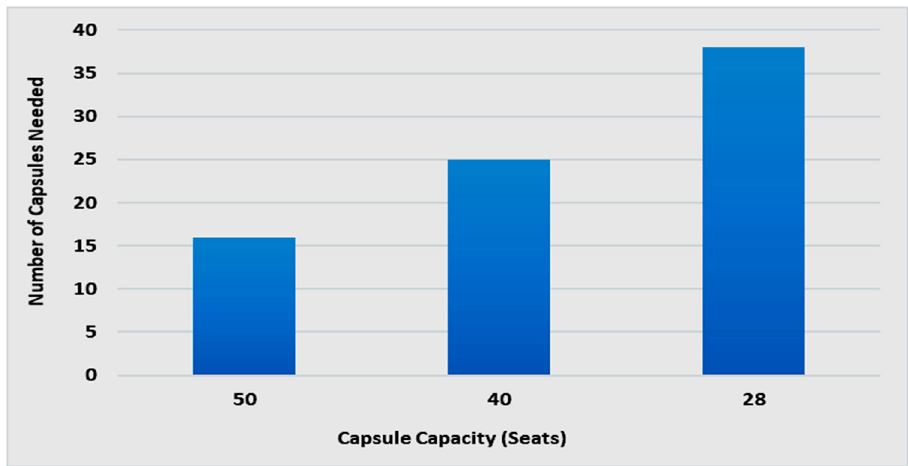
Figure 4. The number of capsules needed under alternative capacity assumptions.